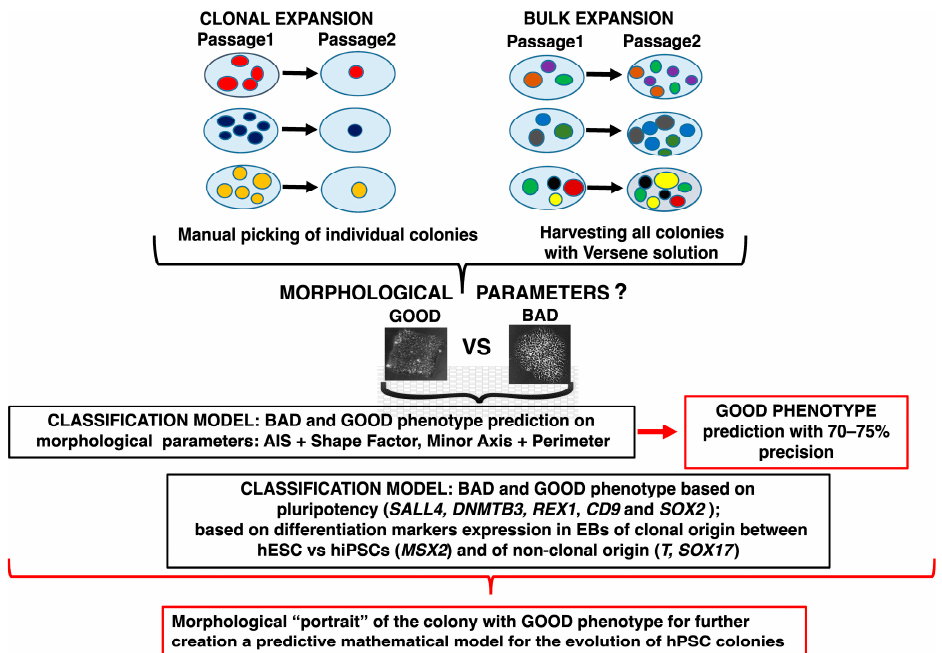
Figure 11. Summary of results. Our paper describes the mathematical classification model built on the morphological parameters of hPSC lines according to their morphological phenotypes and clonal vs. nonclonal (bulk) expansion. The most informative parameters were AIS and Shape factor (for colonies), and Minor axis and Perimeter (for cells). In the next step, we linked pluripotency and differentiation factor expression to the morphological phenotype and to the type of the culture expansion (clonal vs. nonclonal/bulk), revealing the importance of SALL4 , DNMTB3 , REX1 , CD9 , and SOX2 pluripotency markers for the recognition of the colony phenotype, while differentiation marker MSX2 was sensitive for discriminating the clonal origin of the cells. T and SOX17 were informative for distinguishing the nonclonal EB origin. The models demonstrated the possibility of constructing the morphological “portrait” of a colony informative for the automatic identification of the phenotype and for linking this portrait to the expression of pluripotency